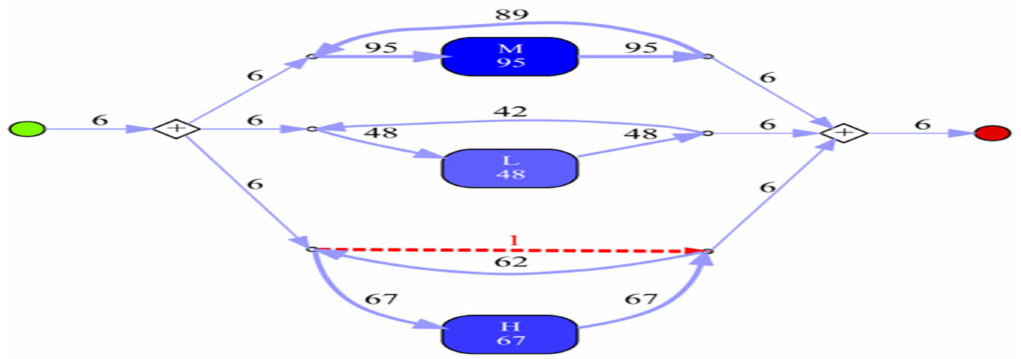
Figure 11. IvM using a default IMf for three classes (lower (L), middle (M), and higher (H)).